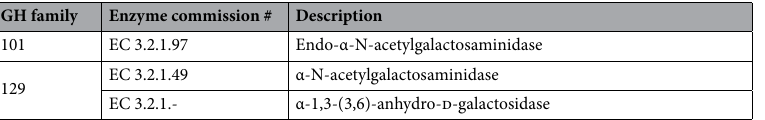
Table 1. Mucin-associated glycosyl hydrolase (GH) families with corresponding enzyme commission numbers and